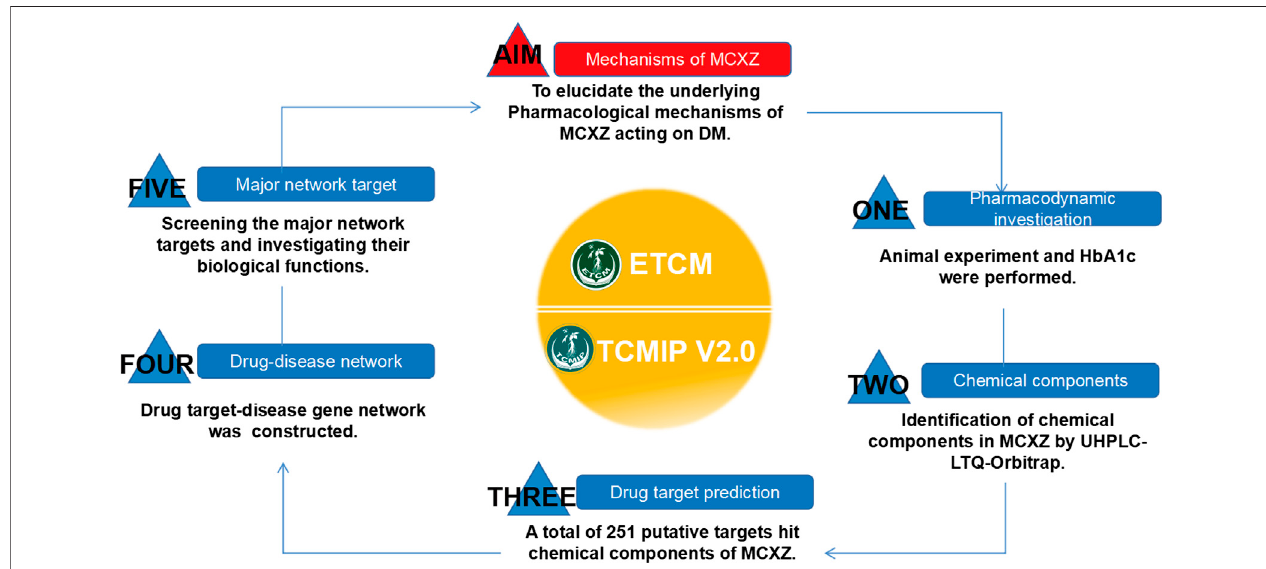
FIGURE 1 | Schematic diagram for revealing the active constituents and the underlying pharmacological mechanisms of MCXZ in the treatment of DM by combining high-throughput technology and integrative pharmacology method.